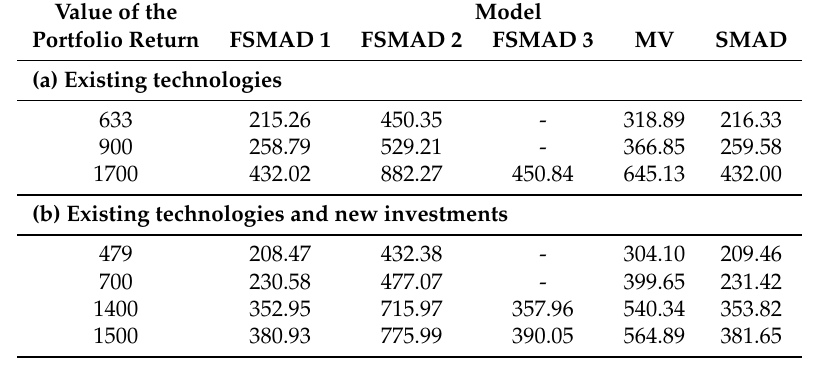
Table 1. Risk values for all models for selected portfolio returns [both in e /kW].